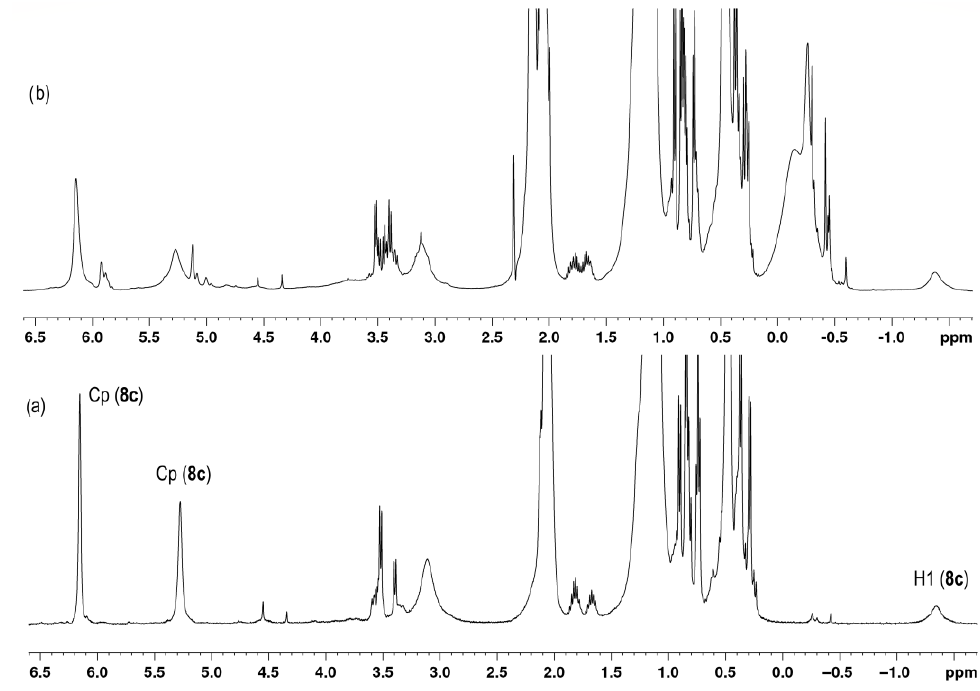
Figure 1. 1 H NMR spectrum of the Me 2 CCp 2 ZrCl 2 ( 1c )−HAlBu i2 −MMAO -12 system in C 7 D 8 (298